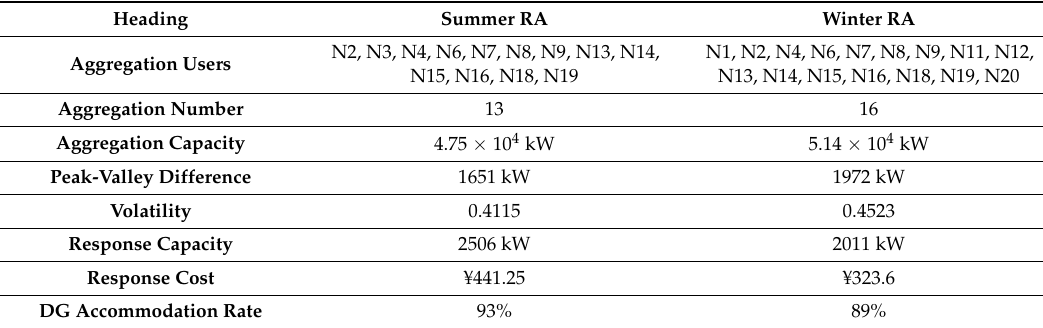
Table 5. The comparison results of RA aggregation in different